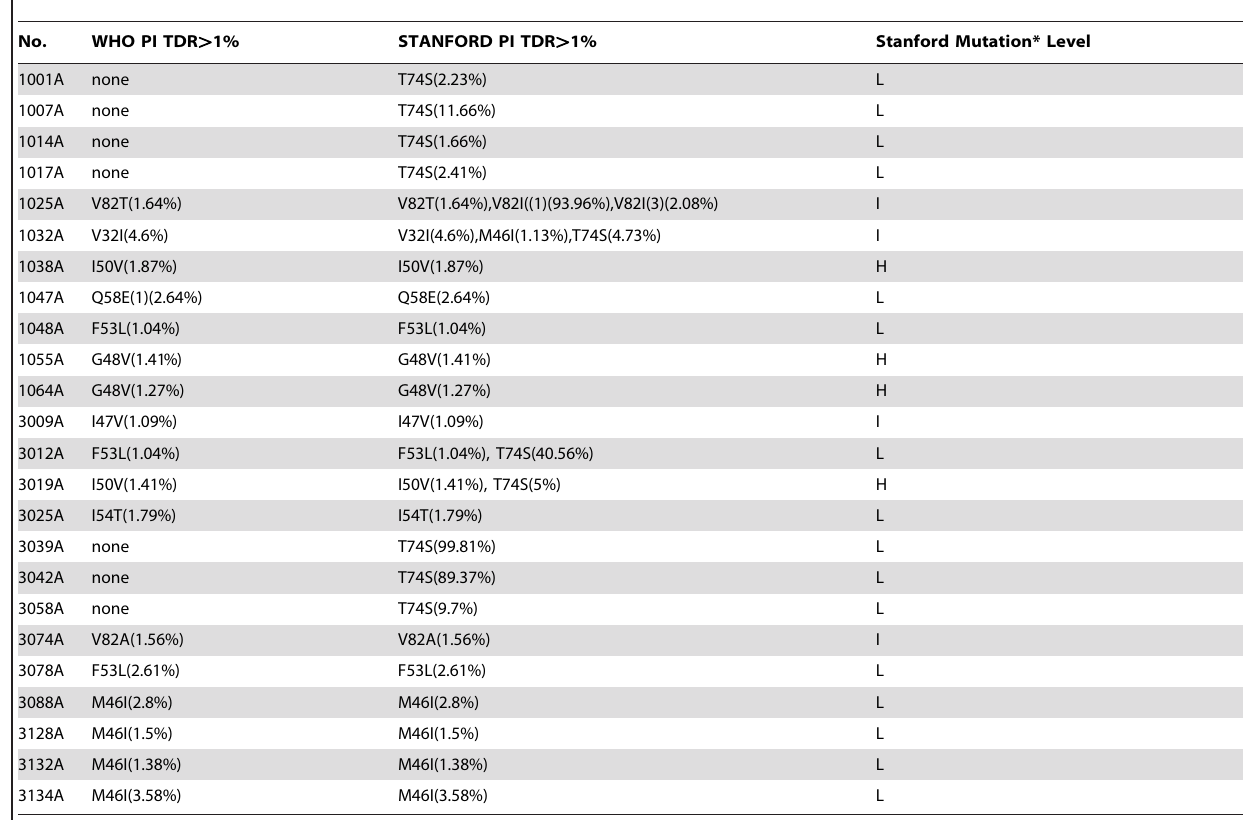
Table 5. HIV drug resistance PI mutation detection by deep